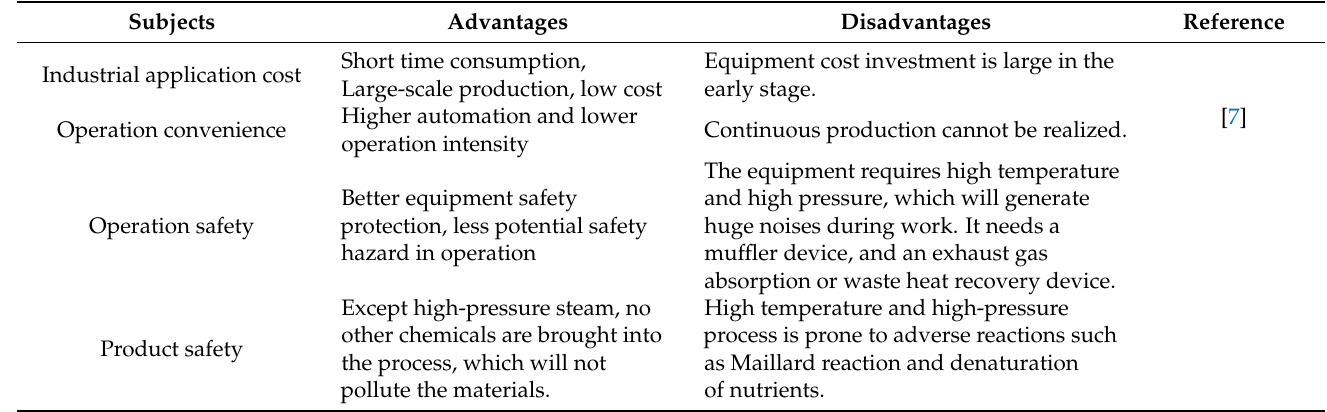
Table 3. Comparison of the advantages and disadvantages of steam explosion and conventional treatment